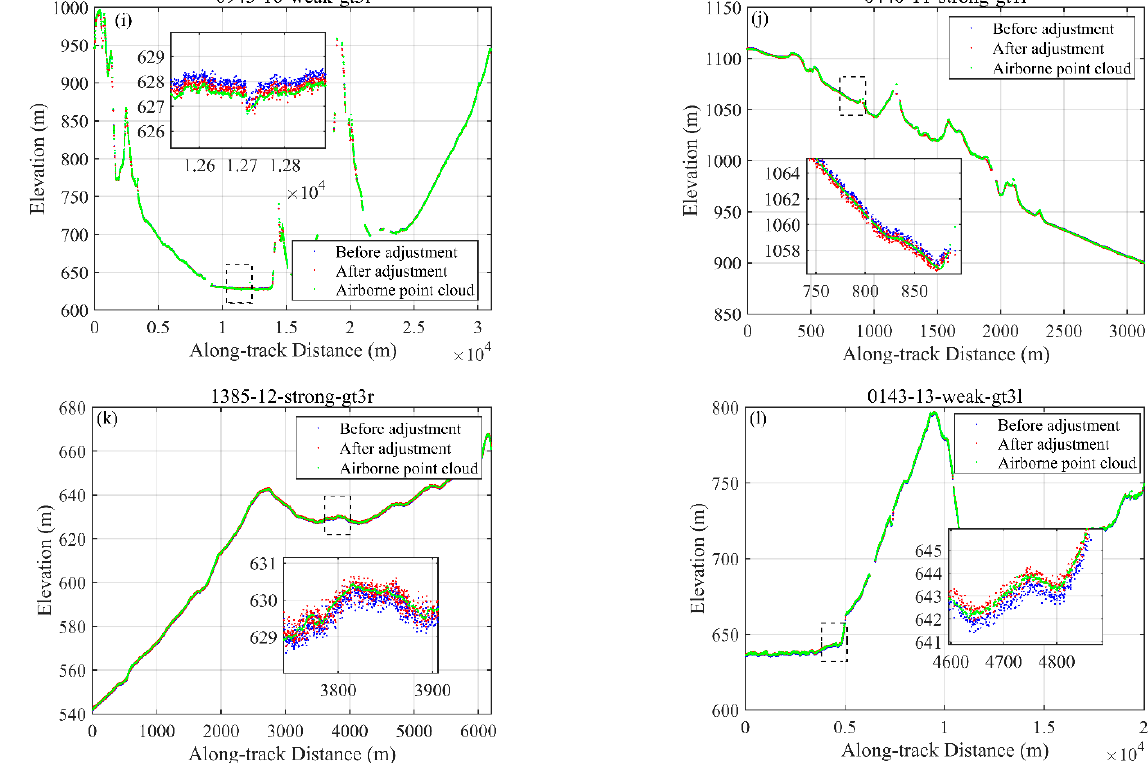
Figure 9. Results of photon distribution of ICESat-2 simulation validation before and after adjustment. The local enlarged image at the position of the black dashed box is given to better show the adjustment results. ( a ) 0501-02-strong-gt1l; ( b ) 1027-03-strong-gt1l; ( c ) 0501-04-strong-gt1l; ( d ) 0082-05-strong-gt2r; ( e ) 0585-06-strong-gt1r; ( f ) 0501-07-weak-gt1l; ( g ) 0943-08-strong-gt2l; ( h ) 1385-09-strong-gt3l; ( i )